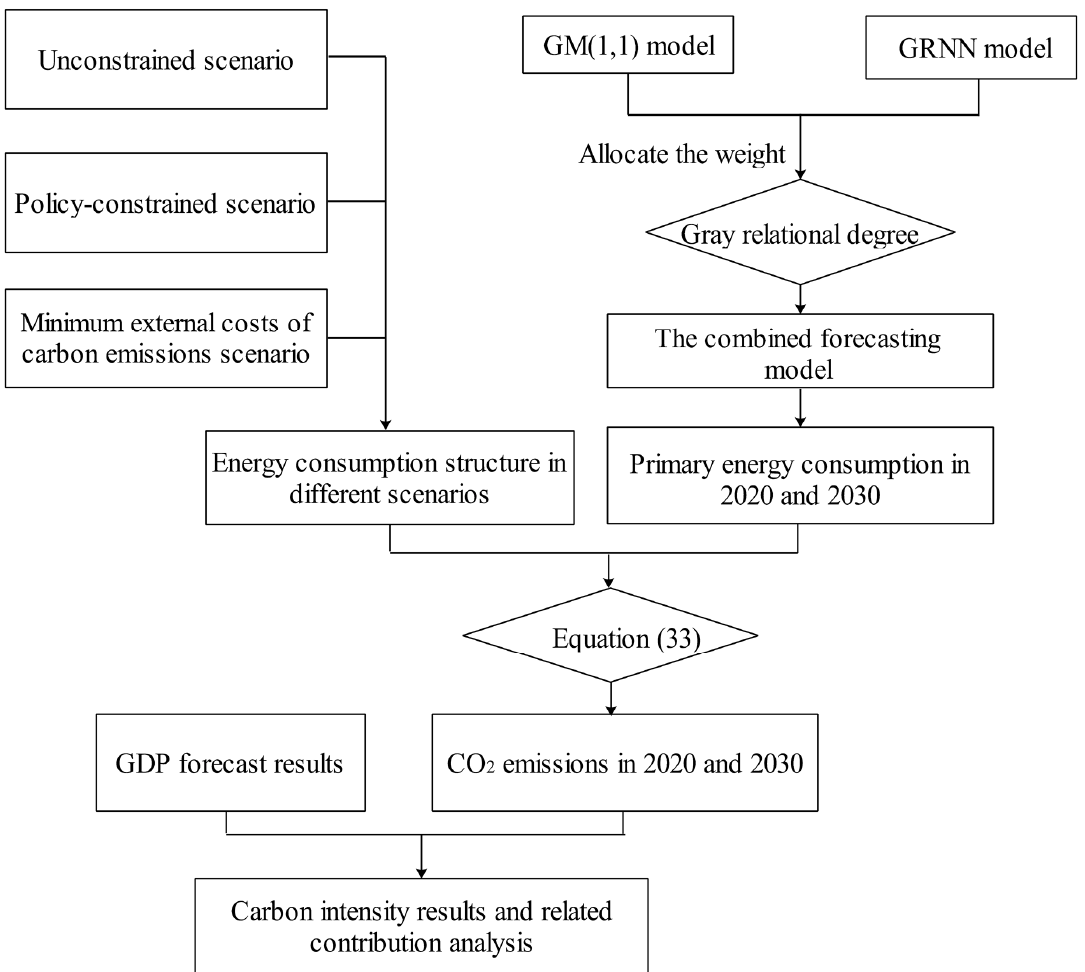
Figure 1. The general flowchart conducted in this paper.